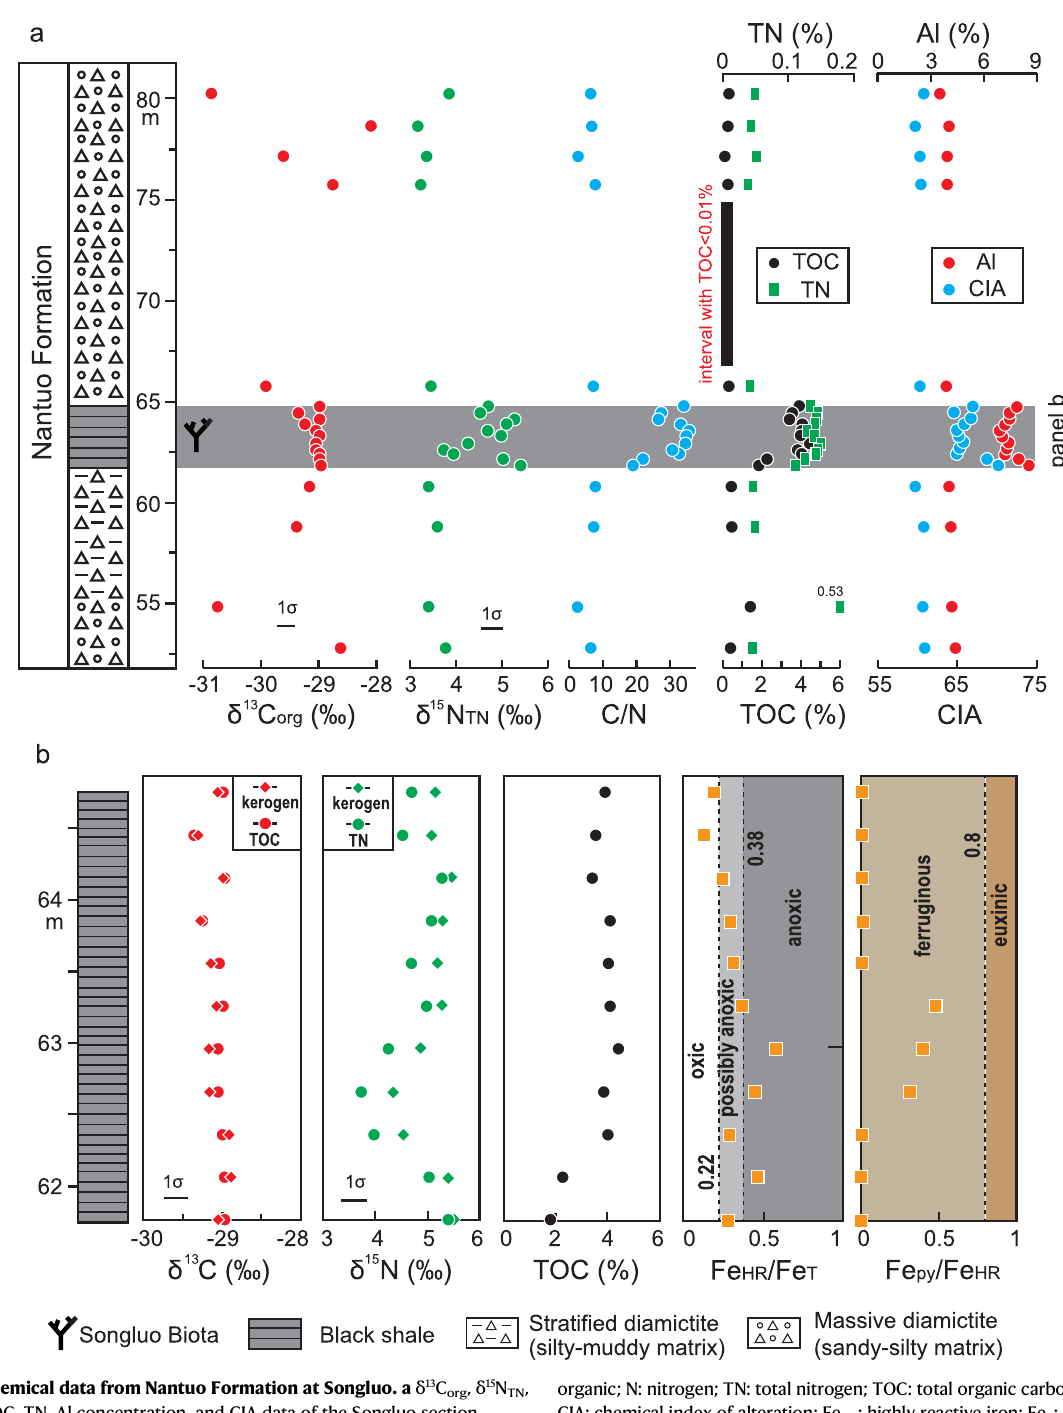
organic; N: nitrogen; TN: total nitrogen; TOC: total organic carbon; Al: aluminum; CIA: chemical index of alteration; Fe HR : highly reactive iron; Fe T : total iron; Fe py : pyrite